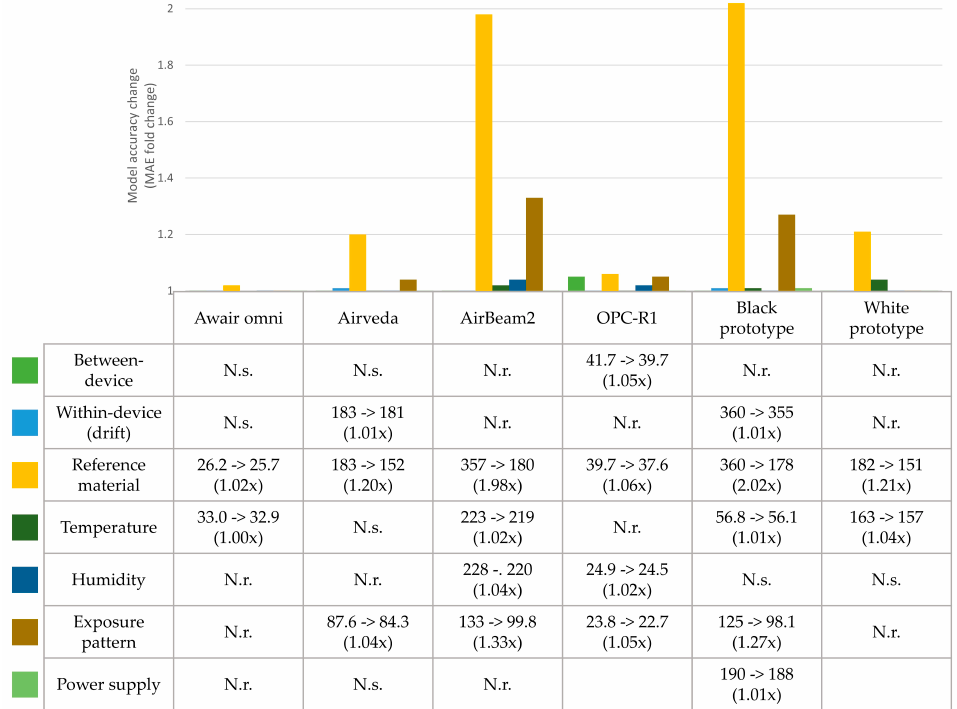
Figure 3. Parameter selection results. Values represent the absolute (in µ g / m 3 ) and fold changes in mean absolute error (MAE) in upon inclusion of the variable in the model. N.s. represents not significant variables ( p > 0.05) and N.r. represents not relevant variables (e.g., the MAE was not